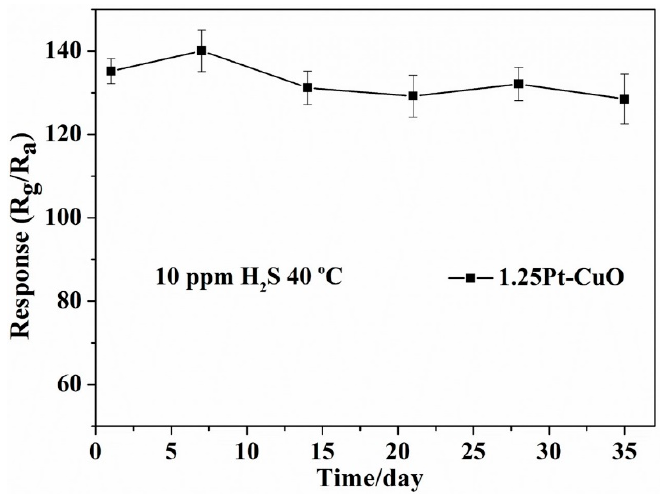
Figure 12. Long-term stability of 1.25Pt-CuO sensor to 10 ppm H 2 S at 40 °C.